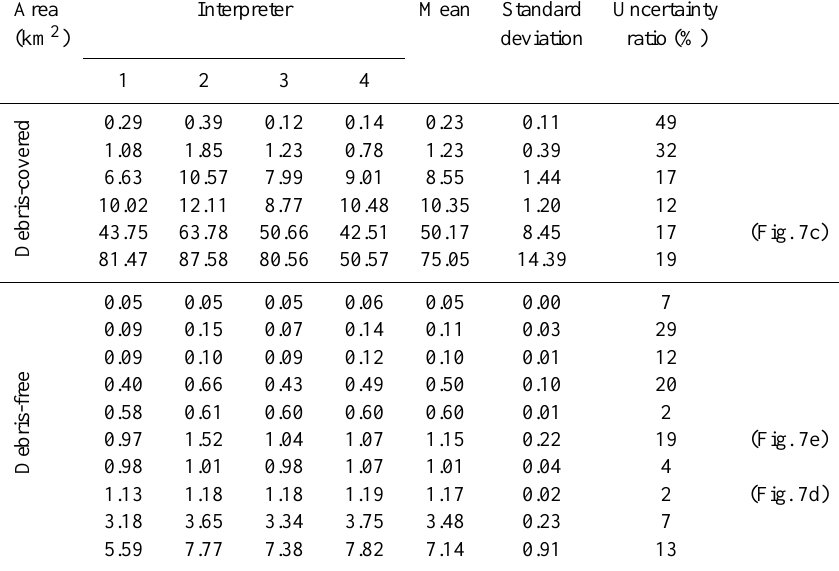
Table 1. Delineated glacier area by authors (km 2 ).